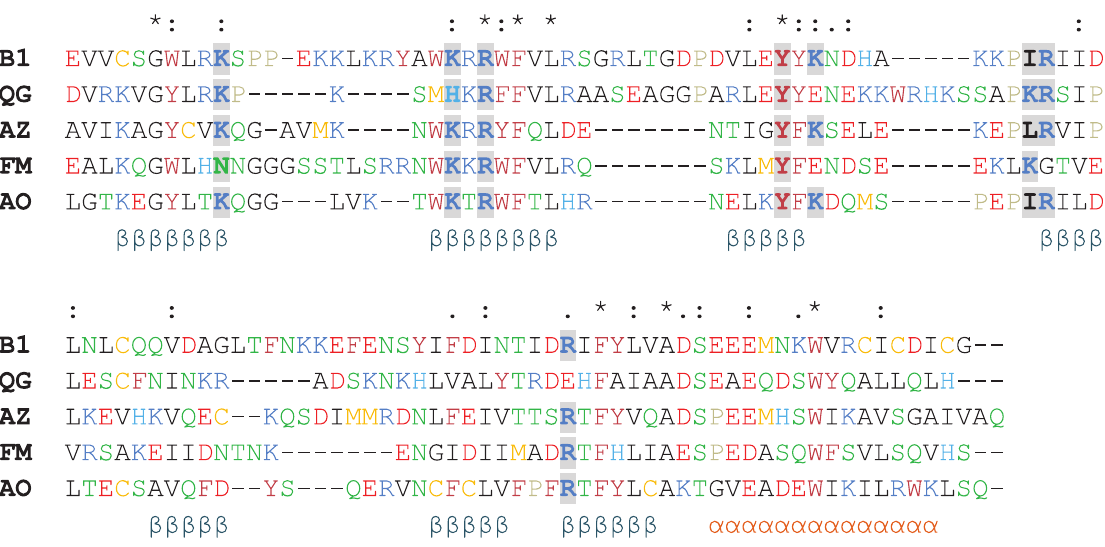
Fig. 2. Sequence alignment of the PH domains. IRS1 (PDB ID: 1QQG), TAPP1 (PDB ID: 1EAZ), Myosin X (PDB ID: 3TFM) and DAPP1 (PDB ID: 1FAO). The secondary structure of the generated GAB1 homology model and the crystal structures of the templates are illustrated, using a for a -helix, b for b -sheet. Except for the highly variable b 1,2 loop regions, the active site residues directly interacting with PtdIns(3,4,5)P 3 are highlighted with shadows.